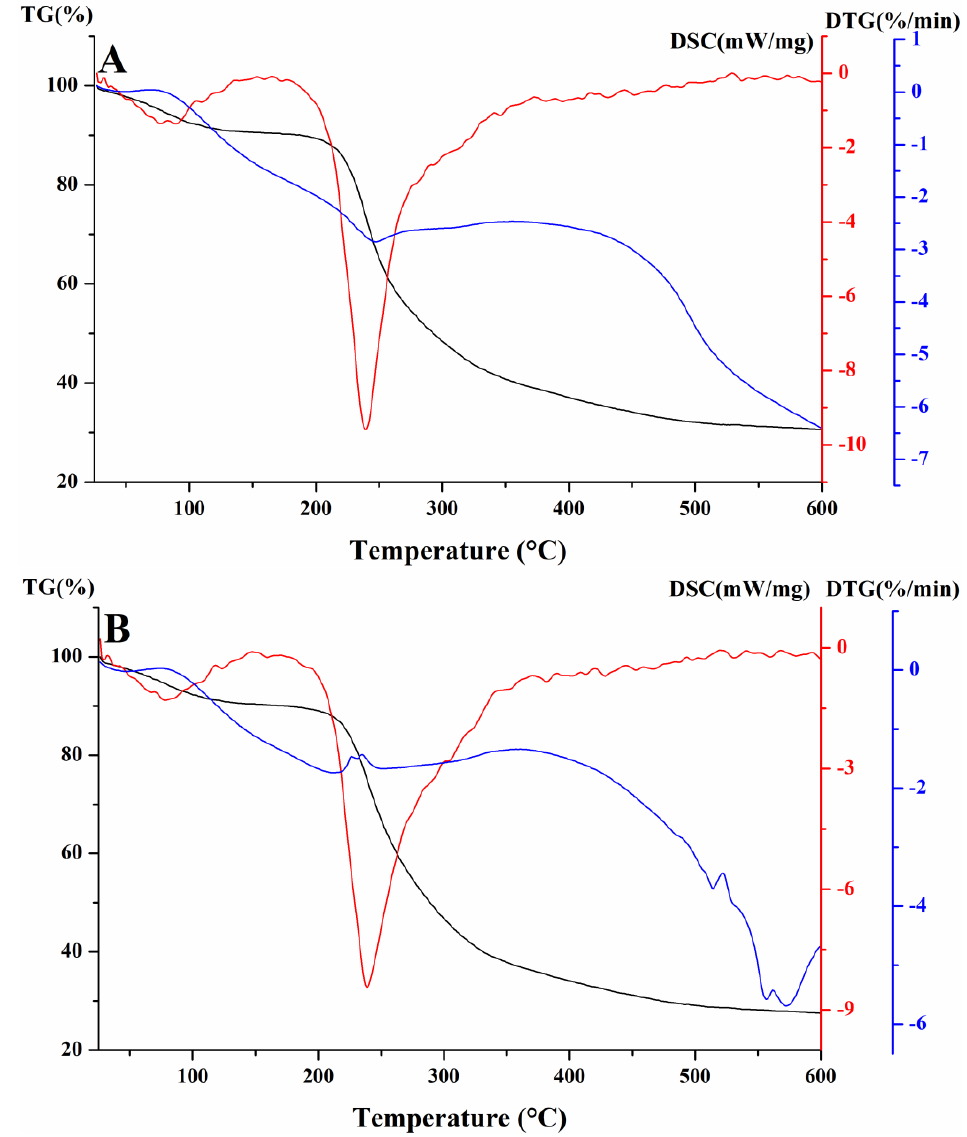
Figure 7. Thermal properties of EAP-H-a1 ( A ) and EAP-H-a2 ( B ).